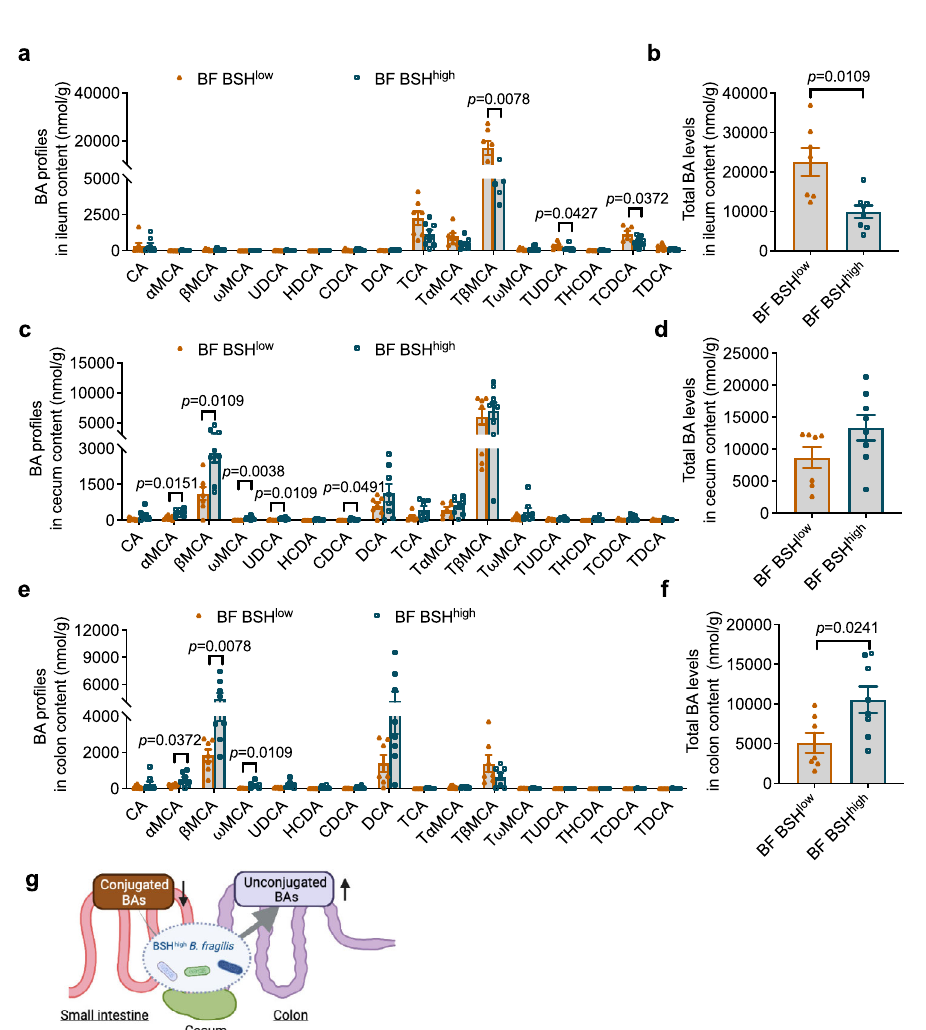
Fig.4|MicrobialBSHoverexpressionin B.fragilis facilitatesbileacidescapeto the colon. a – f HFD-fed Cdx 2 Apc f/w mice were colonized with B. fragilis 638R with lowBSHactivity(BFBSH low )or B.fragilis 638RwithhighBSHactivity(BFBSH high )for 2weeks( n =7miceforBFBSH low ; n =8miceforBFBSH high ).Bileacidpro fi les( a )and totalbileacidlevels( b )intheileumcontents.Mann – Whitney U testwithtwo-sided ( a );two-tailedStudent ’ s t test( b ).Bileacidpro fi les( c )andtotalbileacidlevels( d )in the cecum contents. Mann – Whitney U test with two-sided ( c ). Bile acid pro fi les ( e )